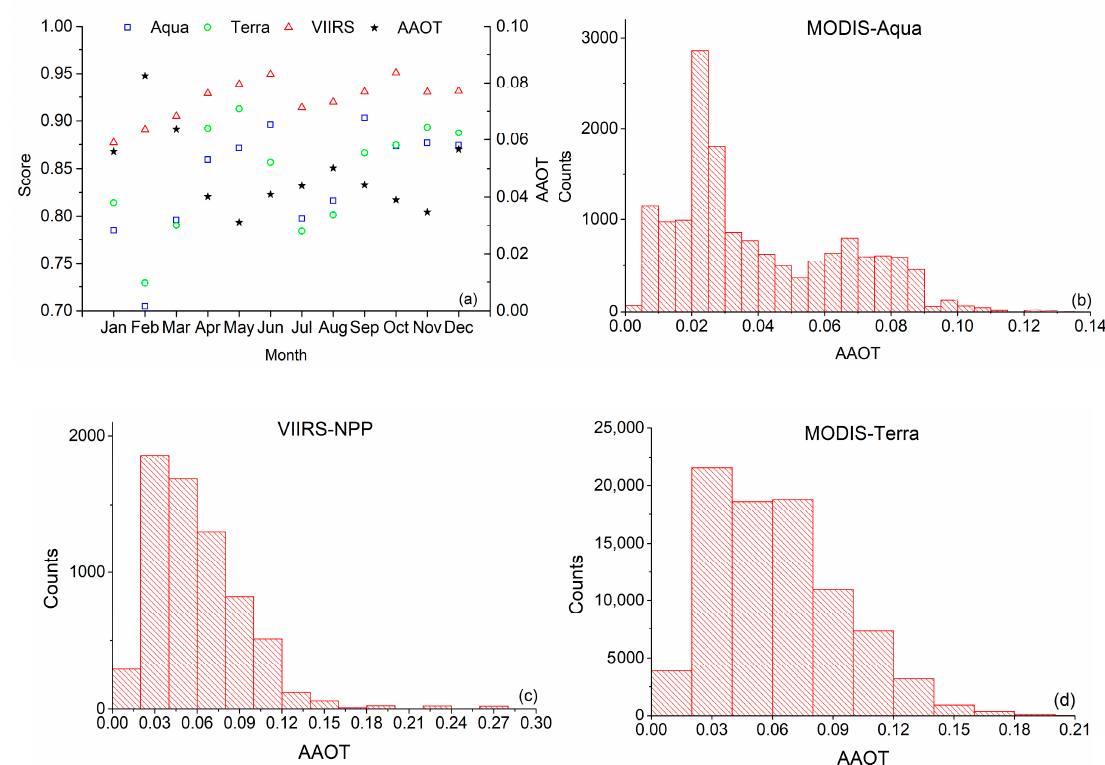
Figure 10. Monthly absorption aerosol optical depth (AAOD) and QA score in the BB, which shows significant negative correlation between AAOD and score ( a ). Histogram of AAODs corresponding to the low quality (score < 0.5) pixels of MODIS–Aqua ( b ), VIIRS–NPP ( c ), and MODIS–Terra ( d ) daily Rrs( λ ) products of BB in February.